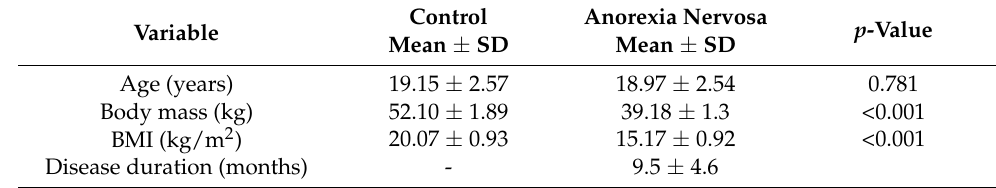
Table 1. Demographic characteristics of control subjects and patients with anorexia nervosa